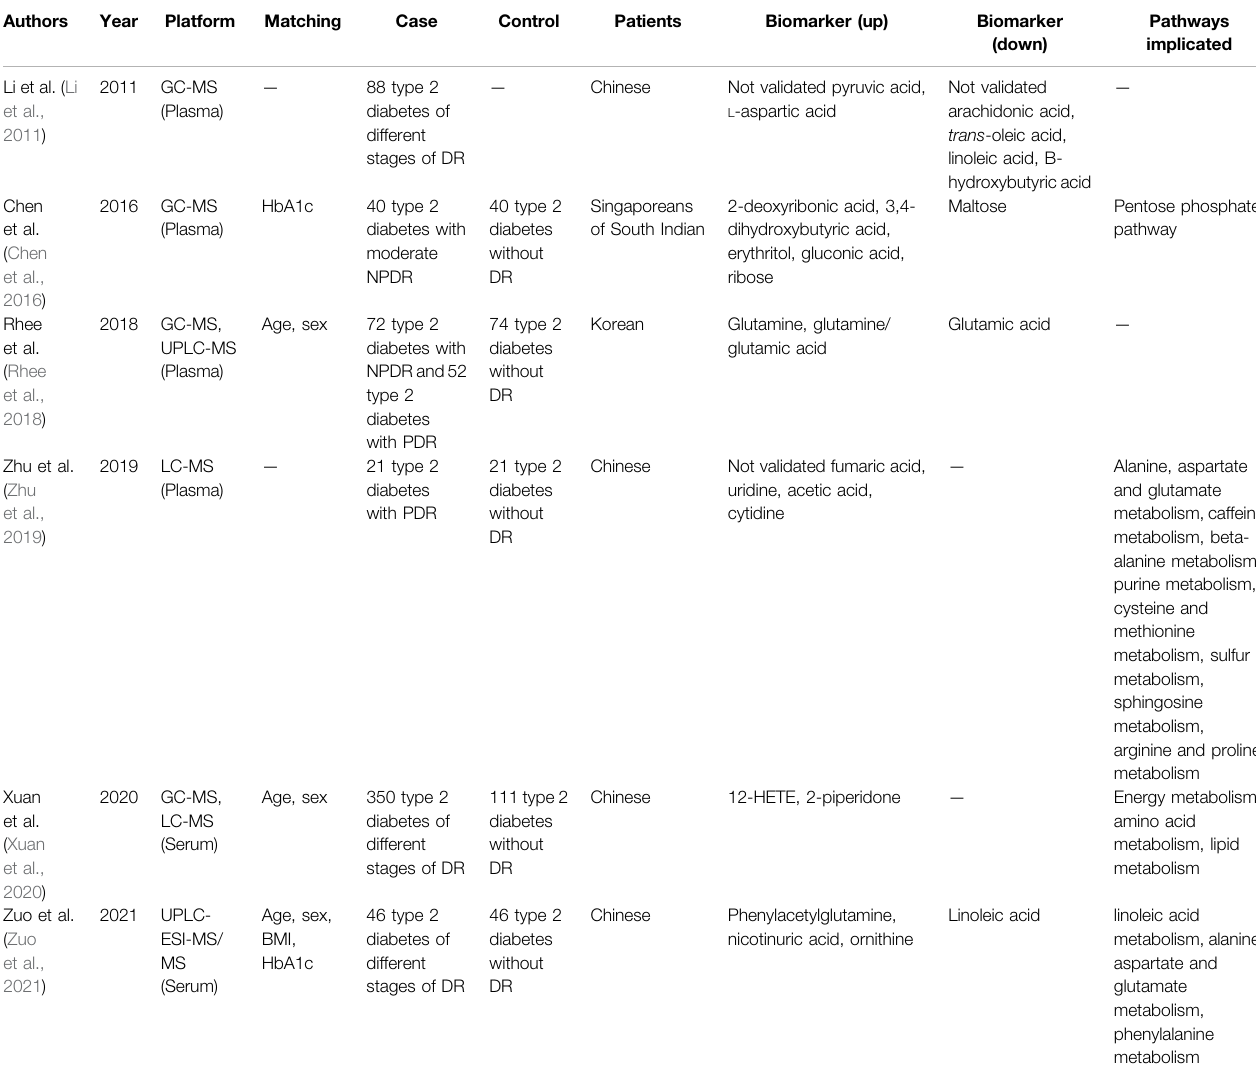
TABLE 2 | Summary of published studies on blood metabolomics of diabetic retinopathy.